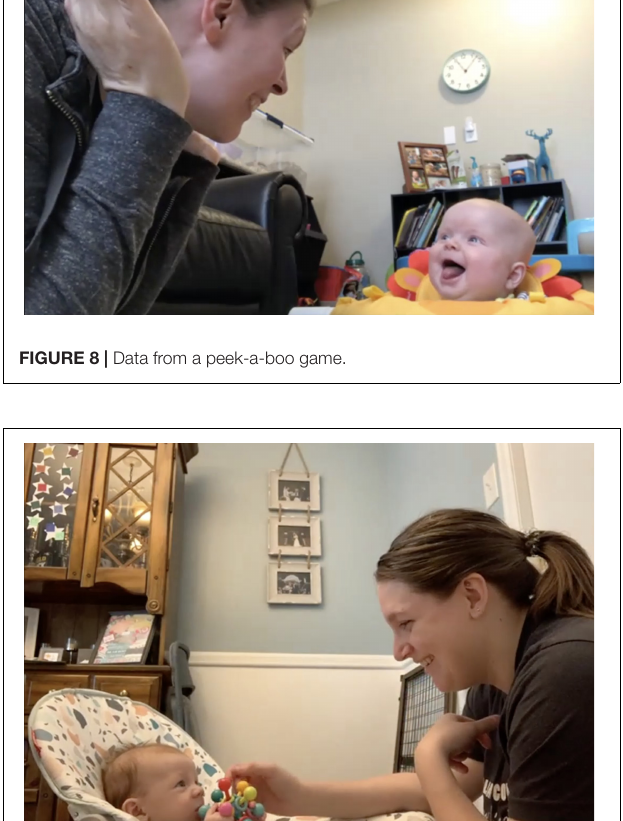
FIGURE 9 | Data from a standardized toy